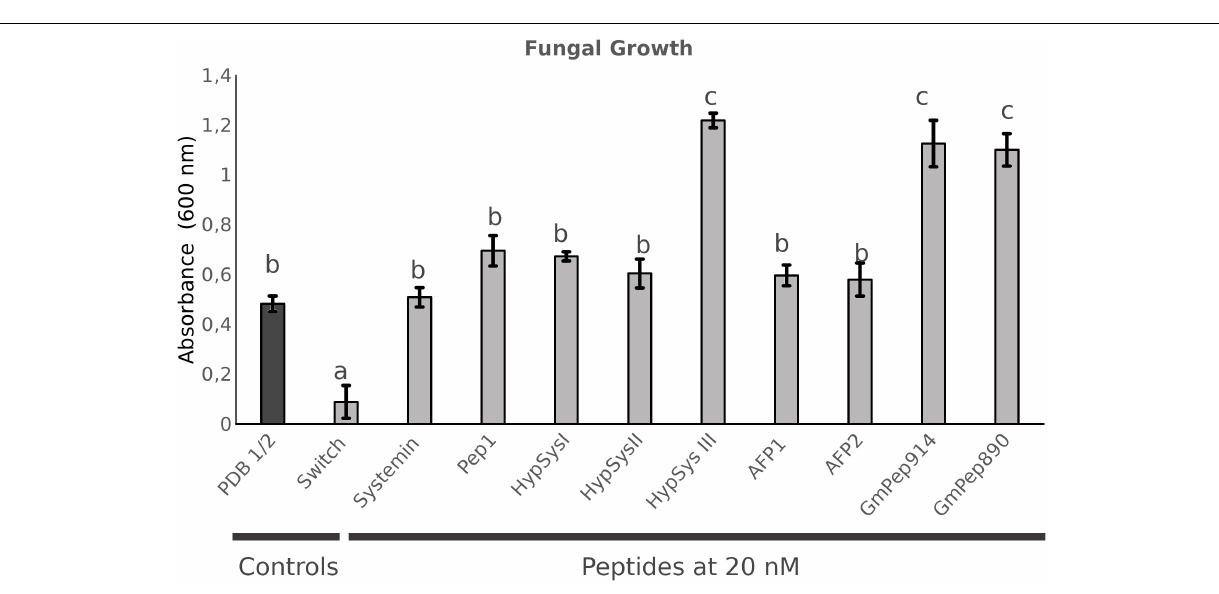
or with the other peptides tested ( Supplementary Figure S6